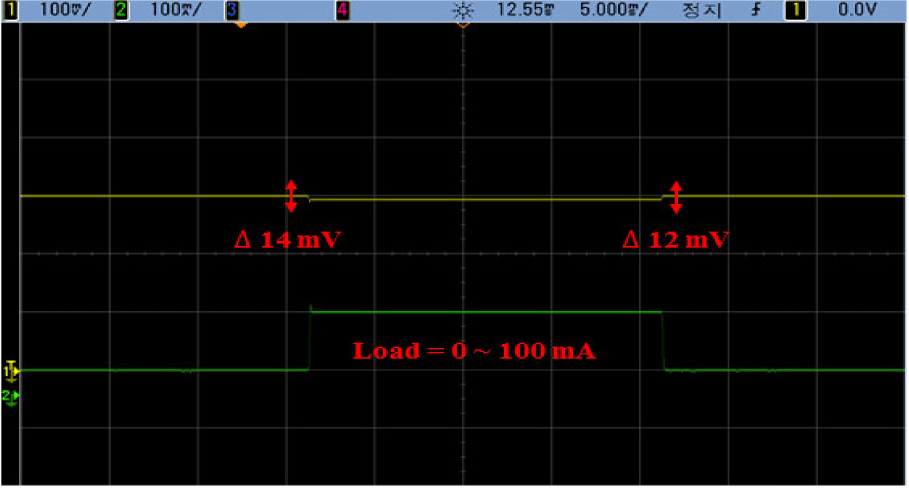
Figure 10. Load transient of the proposed LDO regulator (Load = 100 mA).